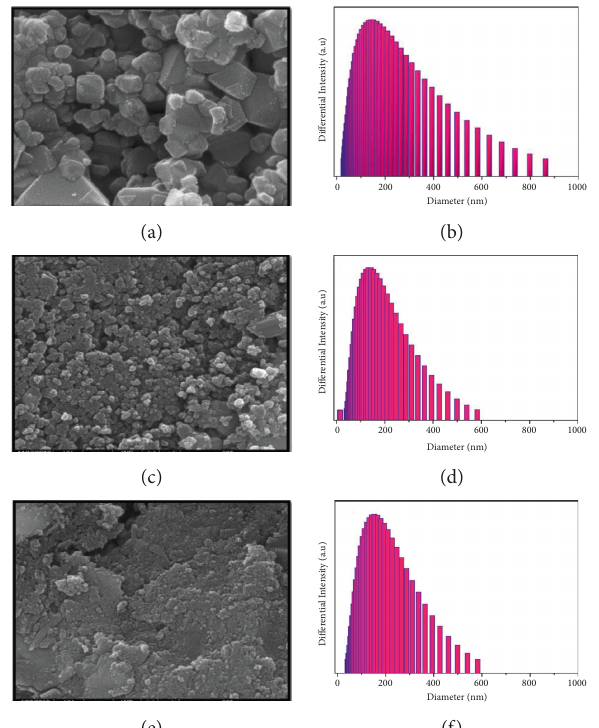
Figure 5: HR-SEM and DLS image of (a and d) NiFe